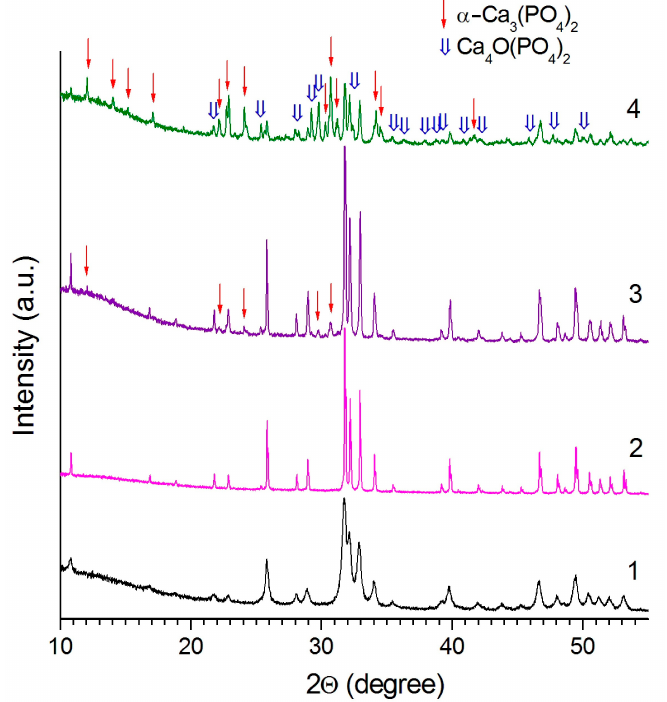
Figure 3. XRD patterns of the initial HA pellet (1) and the HA pellet sintered into the high-temperature furnace at temperatures: 2, 1300 °C; 3, 1400 °C; 4, 1500 °C.